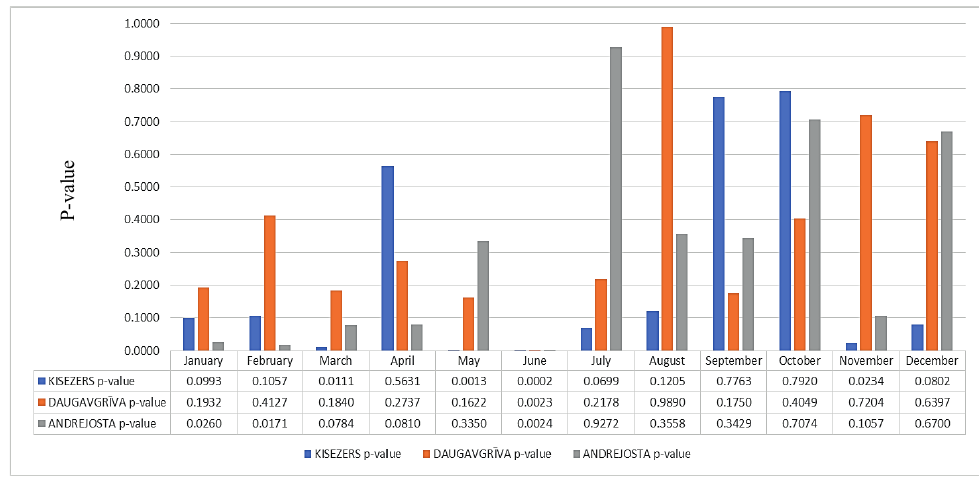
Fig. 2. Mann-Kendall test results of monthly average water level (1948–2017 for the observation stations ‘Andrejosta’, ‘Kisezers’ and 1961–2017 for the observation station